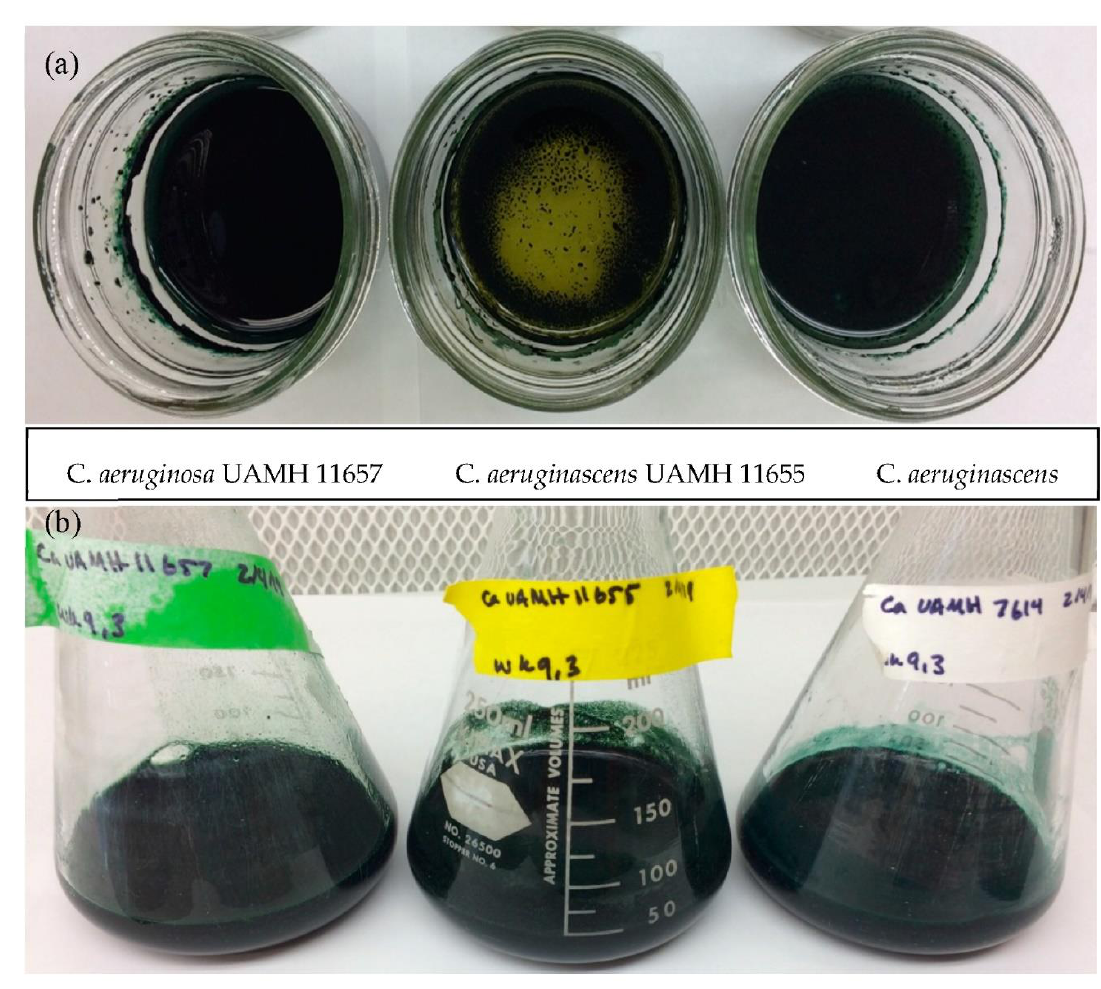
Figure 4. Liquid cultures of tested Chlorociboria species and strains in lab-grade malt extract liquid media at 9 weeks of growth. ( a ) Shaking cultures; ( b ) the same shaking cultures after blending 3 minutes to break up hyphae.